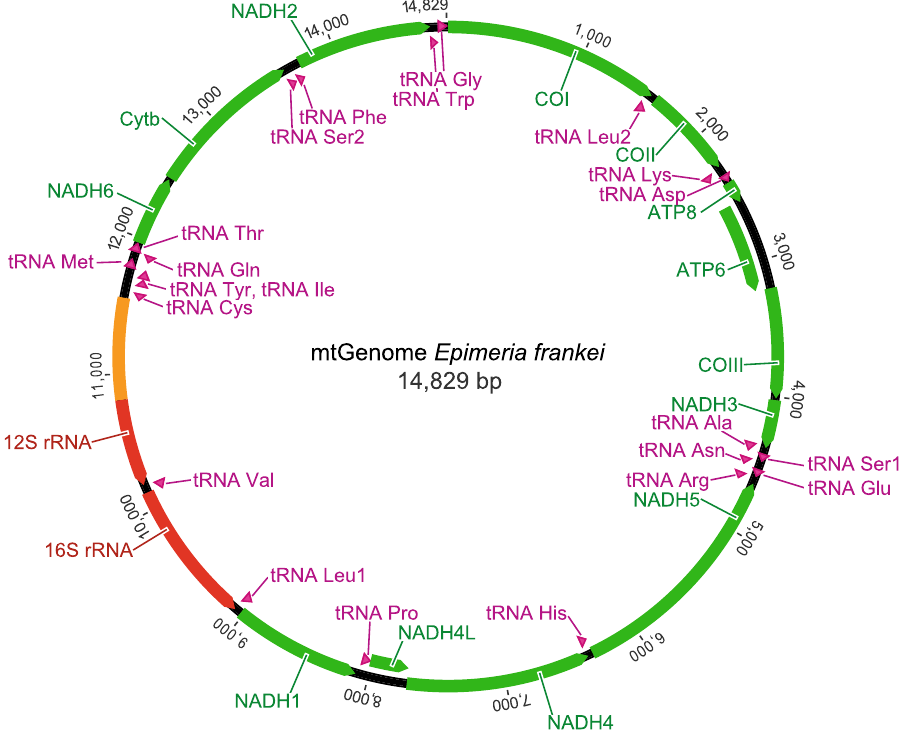
Figure 5. Organization of the mitochondrial genome of Epimeria frankei sp. nov. Protein encoding genes are marked in green, ribosomal RNAs in red, tRNAs in violet, and the putative control region in orange. Abbreviations: ATP6/8: ATPase subunits 6/8; COI-III: Cytochrome c oxidase subunits I–III; NADH2-6/4 L: NADH dehydrogenase subunits 1–6/4 L, and Cyt b: Cytochrome b. All 22 transfer RNA genes are designated by tRNA-X and labeled according to the IUPAC-IUB single-letter amino acid codes. Arrowheads indicate the direction of